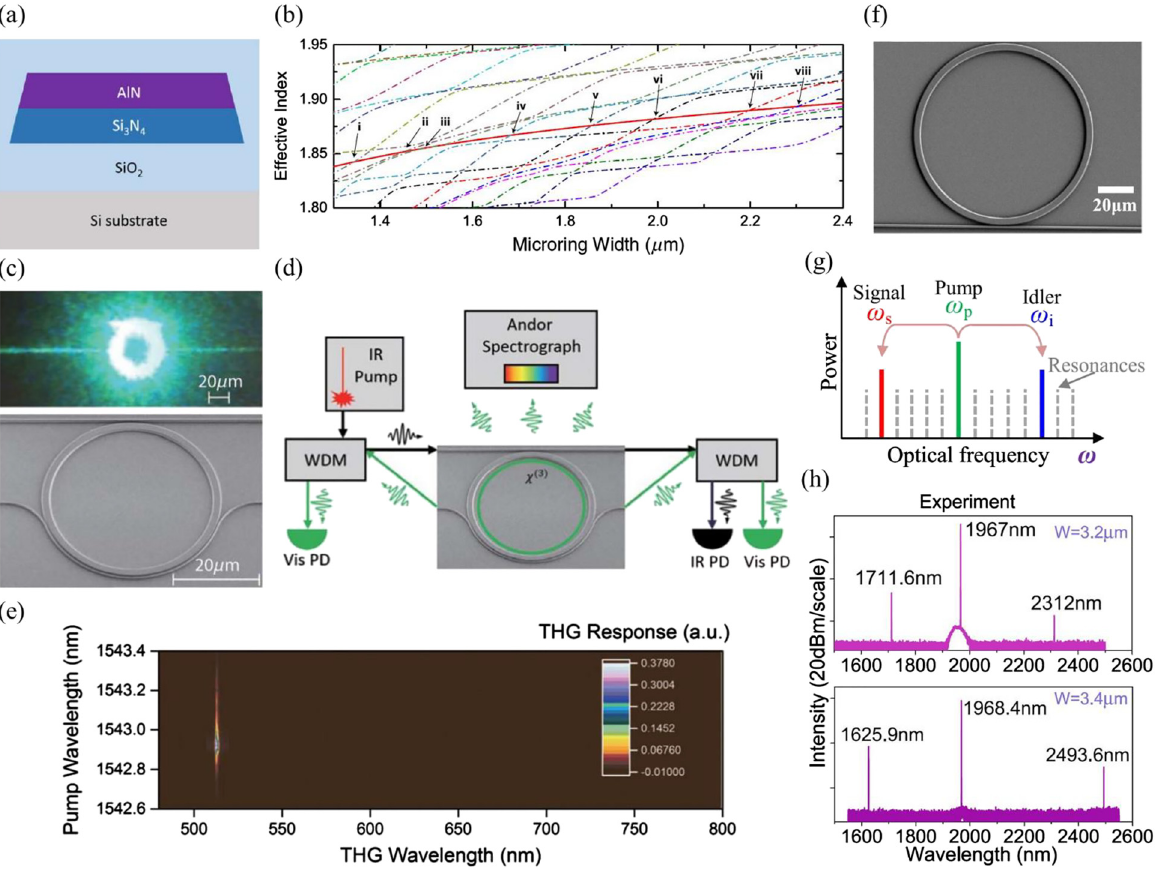
Figure 12: AlN-based integrated devices for third harmonic generation (THG) and optical Kerr parametric oscillation. (a) Schematicof waveguide cross section for THG. (b) The calculated effective index with respect to microring width for phase matching. Solid line represents the fundamental TE mode at pump wavelength around 1550 nm, and dotted lines represent the higher-order TM modes at THG wavelength. The crossing points represent phase-matching condition. (c) Top panel: optical image of the microring under THG operation. The scattered green color THG signal can be observed. Bottom panel: SEM image of the waveguide without cladding. (d) THG characterization setup: a tunablelaser around 1550 nm is used as pump, WDMs are used to split the pump and THG signal, and an Andor Spectrographis used to capture the scattered light above the device. (e) Captured spectrograph shows that there is signal at THG wavelength, but no signal at SHG wavelength. (a) – (e) Adapted with permission from [131] © The Optical Society. (f) SEM image of microring resonator ( R = 50 μ m) without top cladding.(g)Schematicof χ (3)